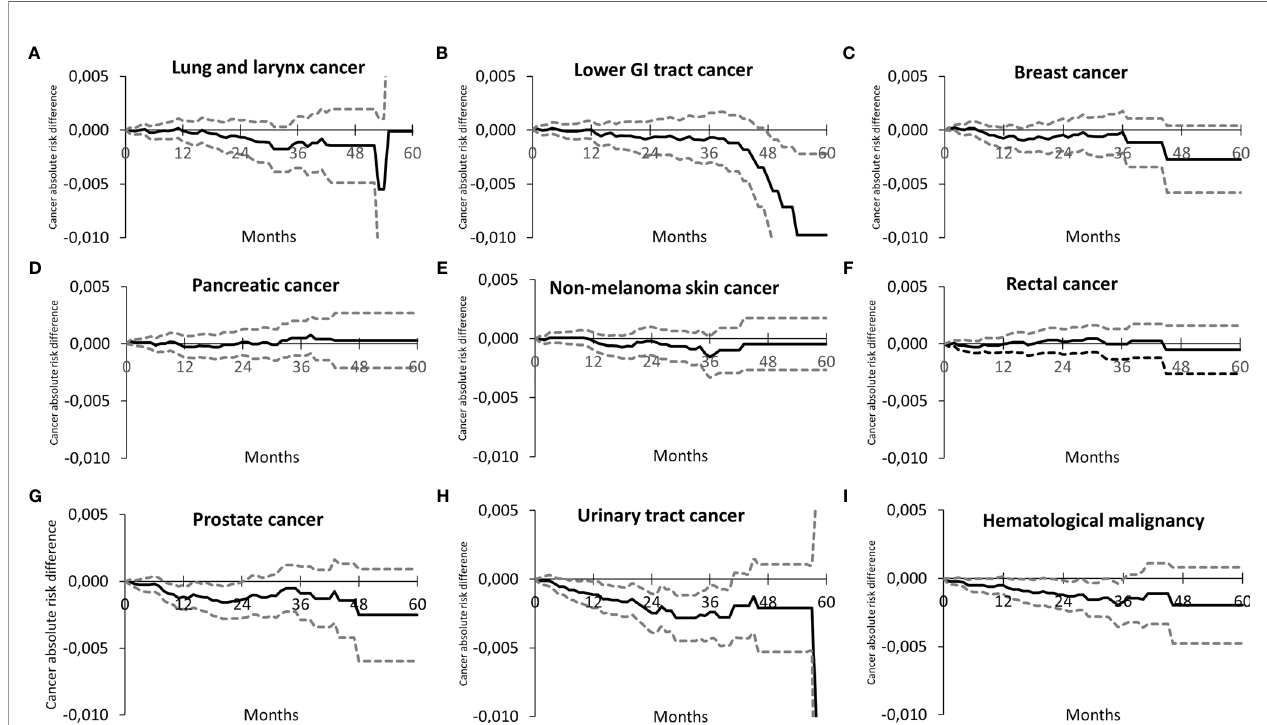
FIGURE 3 | Absolute risk difference between the SGLT2i arm and the DPP-4i arm as a function of time for different cancer sites. It is to be noted that a negative difference indicates a lower actual risk for the SGLT2i arm as compared to the DPP-4i arm. The dotted lines represent the corresponding 95% con fi dence intervals. The order of individual sites is the same as in Figure 2 , i.e. (A) lung and larynx cancer, (B) lower GI tract cancer, (C) breast cancer, (D) pancreatic cancer, (E) non- melanoma skin cancer, (F) rectal cancer, (G) Prostate cancer, (H) urinary tract cancer, (I) hematological